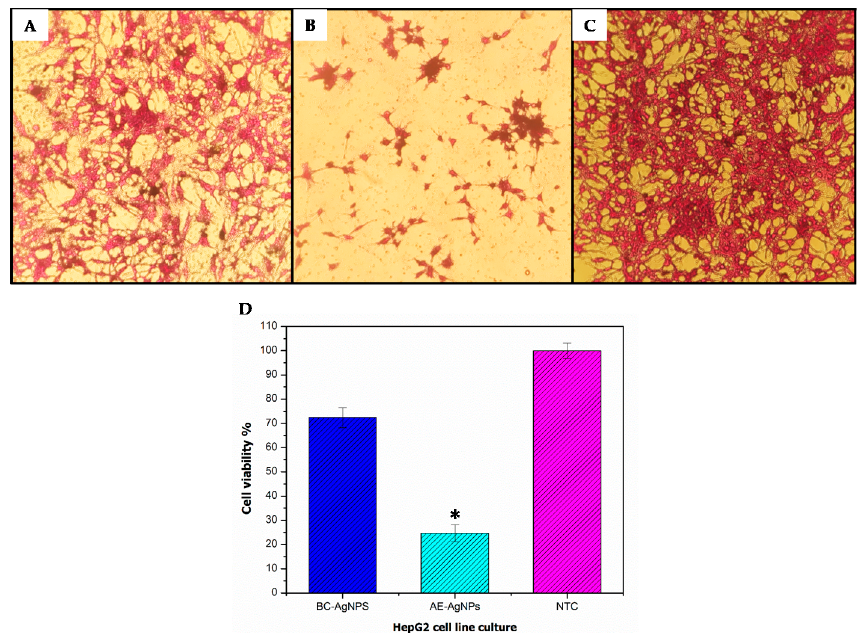
Figure 5. Cytotoxic e ff ects of biologically synthesized AgNPs on HepG2 cells upon 24-h treatment with 200 µ g / mL concentration. Untreated cells were included as controls. Microscopic images of HepG2 cells (treated and untreated). Magnification = 200 × . ( A ) Image of BC-AgNPs cytotoxic activity; ( B ) image of AE-AgNPs cytotoxic activity; ( C) image of Non-treated HepG2 cells; ( D ) percentage viabilities of cells relative to untreated control (Mean ± SD). Each sample was studied in triplicates (biological replicates), and the experiment was performed twice (technical replicates). * p ≤ 0.05 (two tailed t-test) when compared to NTC (non-treated cells).